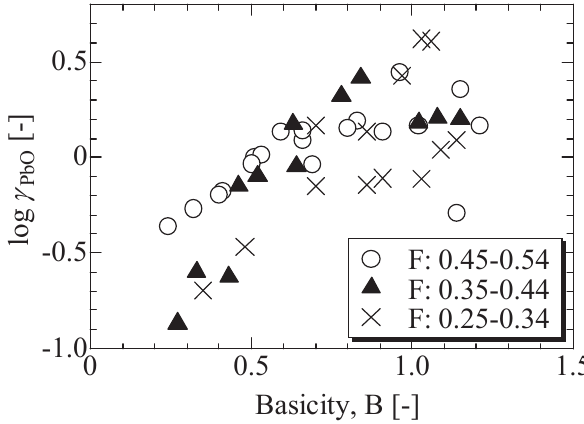
Figure 2. Influence of basicity (B) on the activity coeffi- cient of PbO .